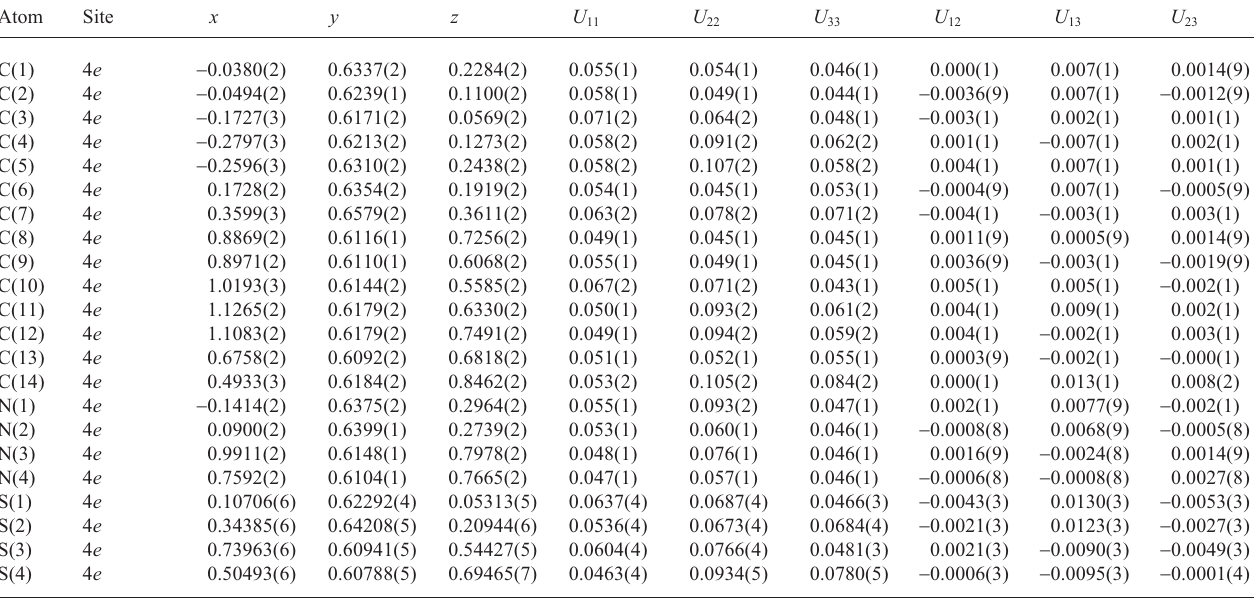
Table 3. Atomic coordinates and displacement parameters (in Å 2 )